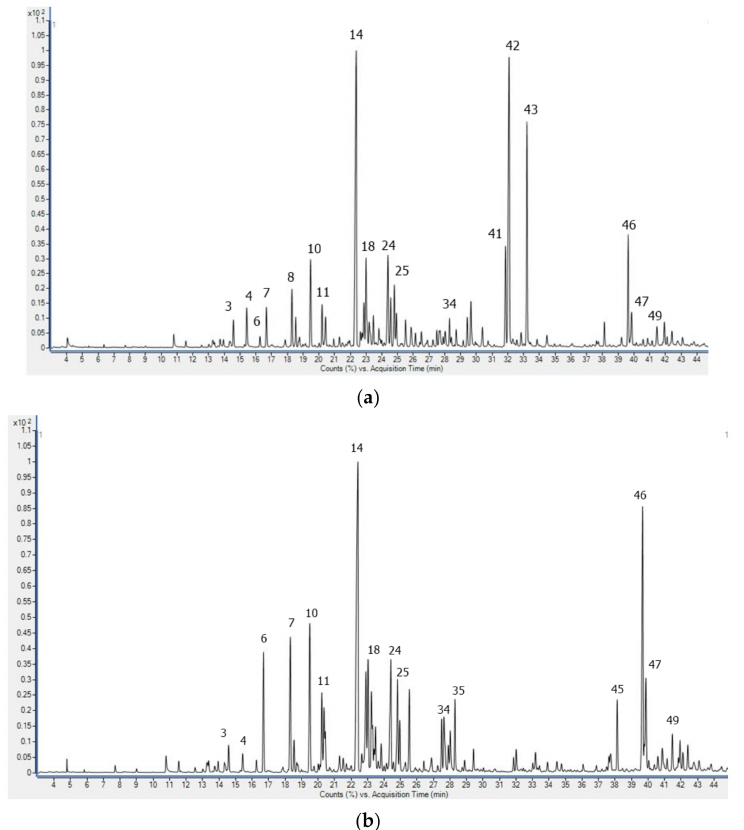
Figure 2. GC-MS total ion chromatogram of sea fennel hydrolates obtained hydro-distillation ( a ) and microwave-assisted hydro-distillation ( b ). Peak assignment is given in Table